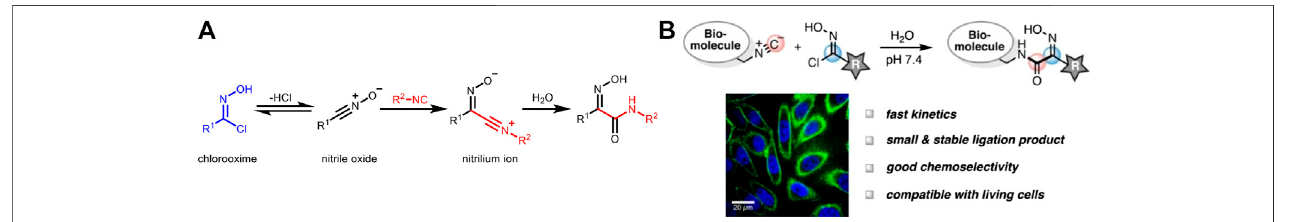
FIGURE5|(A) Mechanismofthereaction betweenisocyanidesand chlorooximes. (B) Isocyanide-chlorooxime ligationforthelabelingofbiomoleculesinlivecells. Re-printed with permission from American Chemistry Society Publications 2019 (Schäfer et al., 2019).